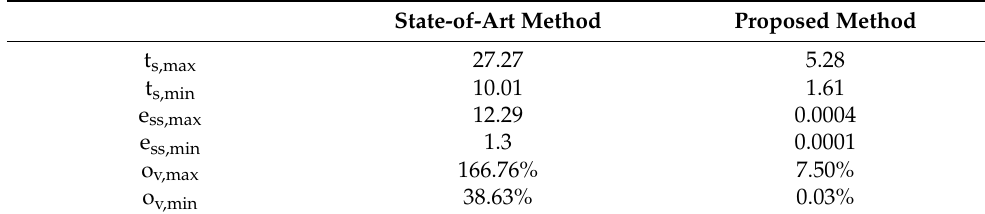
Table 5. Comparative analysis III of performance between method in [5] and proposed